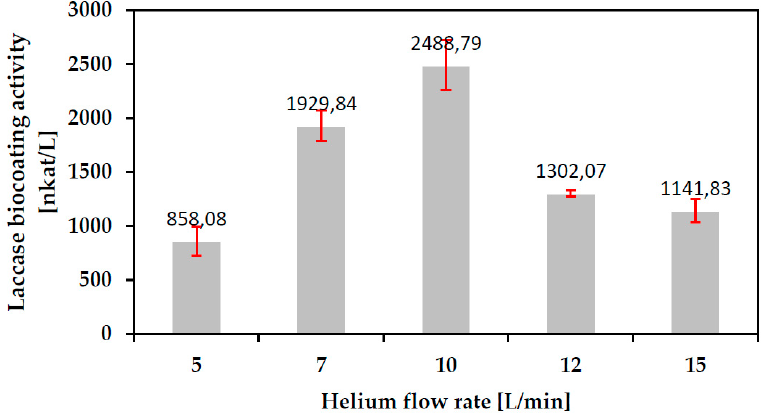
Figure 7. Laccase biocoating activity vs. Helium carrier gas flow rate for as-deposited coatings on glass slides (U = 3 kV).